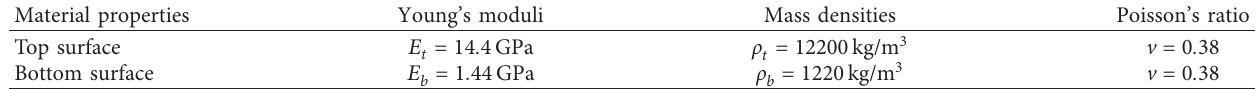
Table 2: Material properties of the FGP plate.